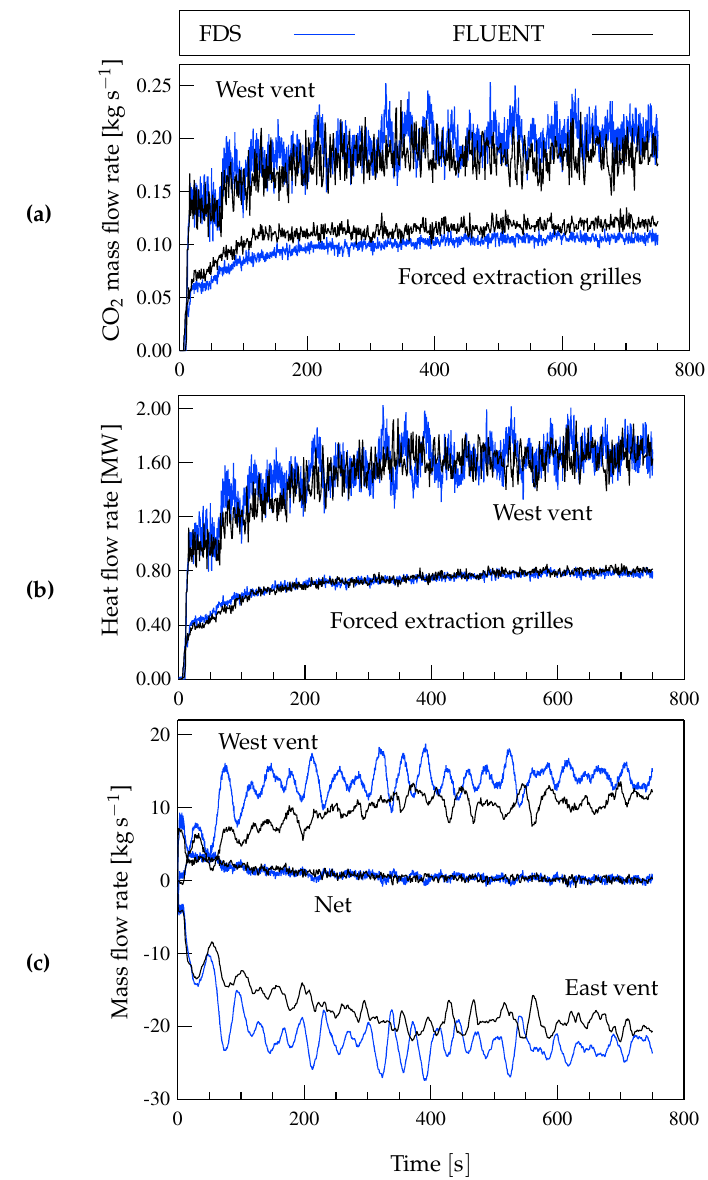
Figure 19. (a) Mass flow rates of CO 2 , (b) heat flow rates, and (c) mass flow rates (including the net mass flow rate leaving the compartment) through the ventilation systems obtained with FDS and FLUENT using the simplified fire model with T in = 1500 K (Case G-4).